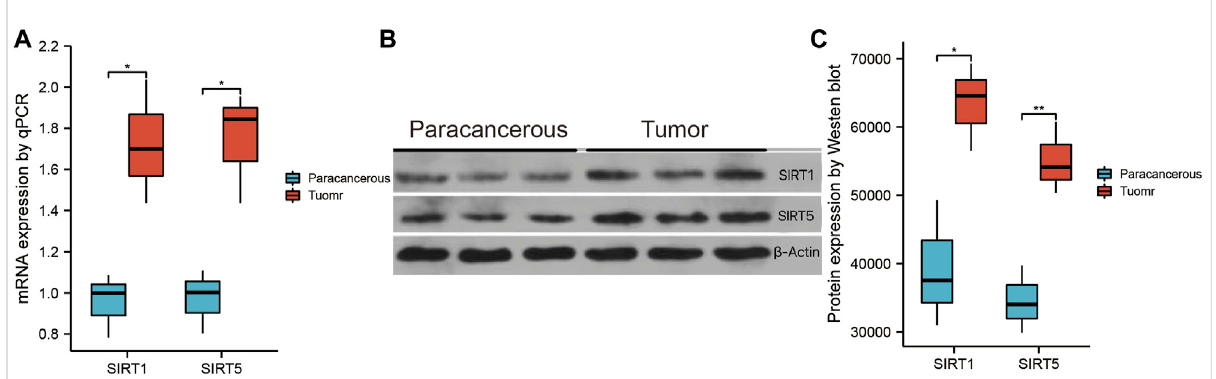
FIGURE 10 Validation of SIRT1 and SIRT5 expression. (A) qPCR was used to detect the differential expression of SIRT1 and SIRT5 between glioma and paracancerous tissue. (B) Western blotting was used to detect differential expression of SIRT1 and SIRT5 between glioma and paracancerous tissue (* p < 0.05, ** p < 0.01, *** p < 0.001, ns: p >